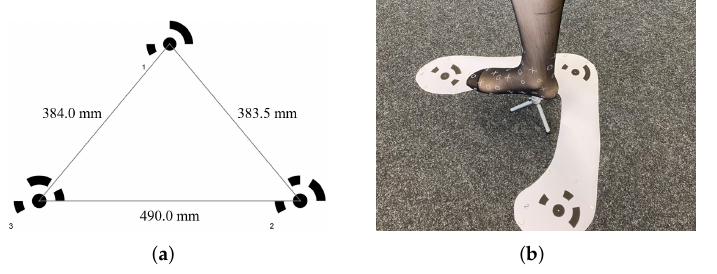
Figure 10. Experimental setup for photogrammetry: ( a ) target arrangement; ( b ) example image used for photogrammetry.